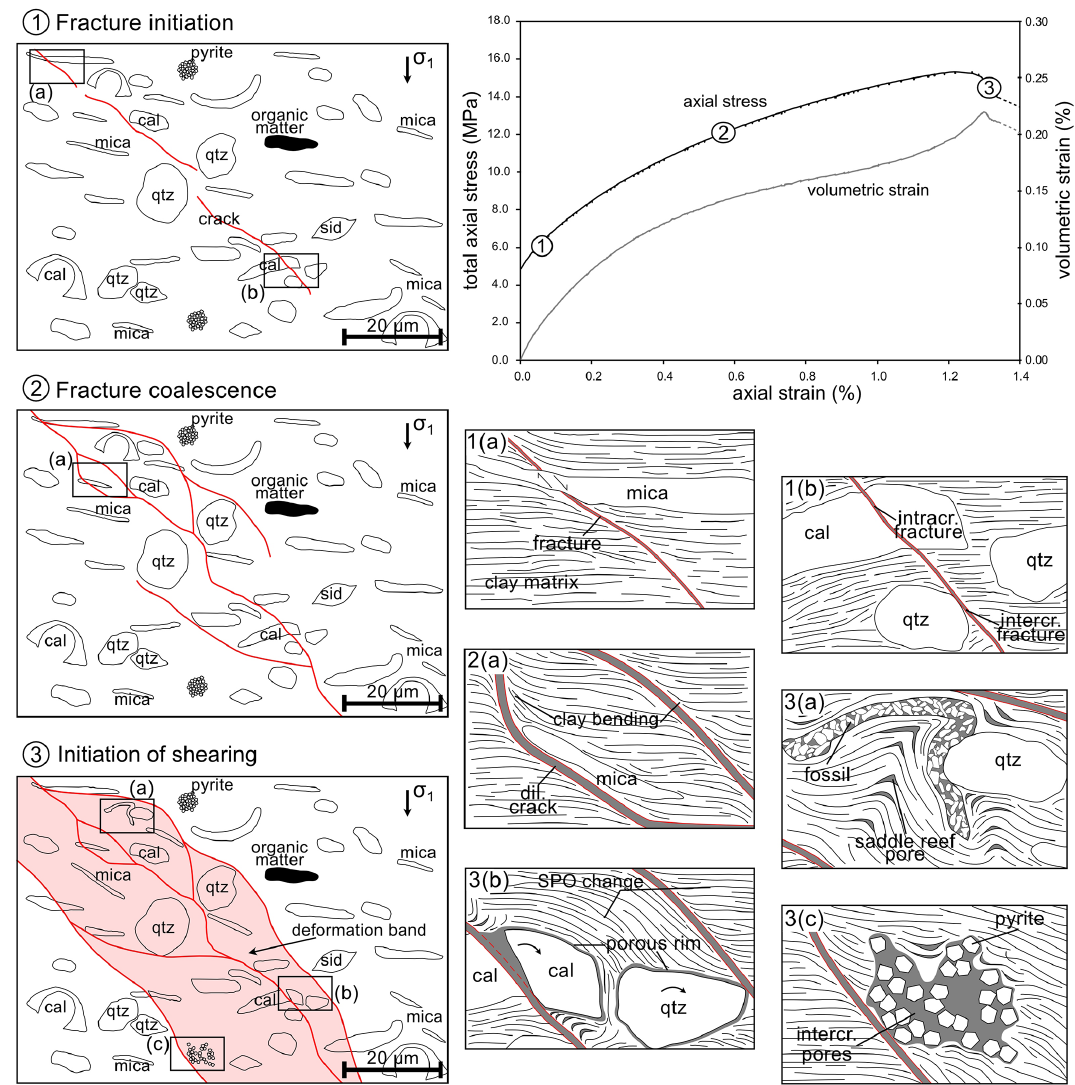
Figure 9. Deformation model for experimentally deformed OPA in a triaxial test consisting of different stages of damage accumulation: stage 1 is associated with fracture initiation whereby fractures form along a preferred oblique orientation. Stage 2 is characterised by mi- crofracture coalescence and the formation of anastomosing fracture networks. Here, fractures dilate and clay particles bend towards the fractures. In stage 3, deformation bands show highly deformed microstructures such as strained fossils, delaminated clay aggregates, dilatant microfractures, and an SPO change. Within these bands, porosity is increased by “saddle-reef pores” between clay layers, collapsed fossil shells, porous rims around larger grains, and the formation of intracrystalline pores in pyrite